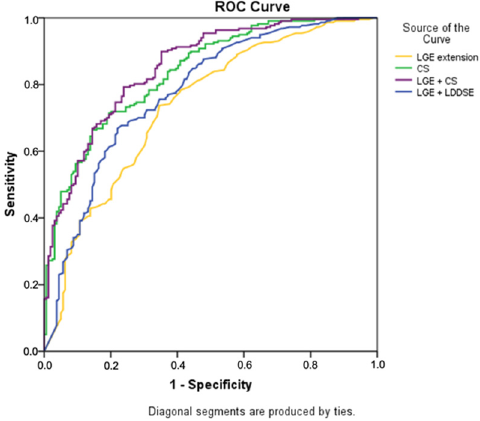
CS, circumferential strain. LDDSE, low dose dobutamine stress echocardiography. LGE, late gadolinium enhancement transmurality.